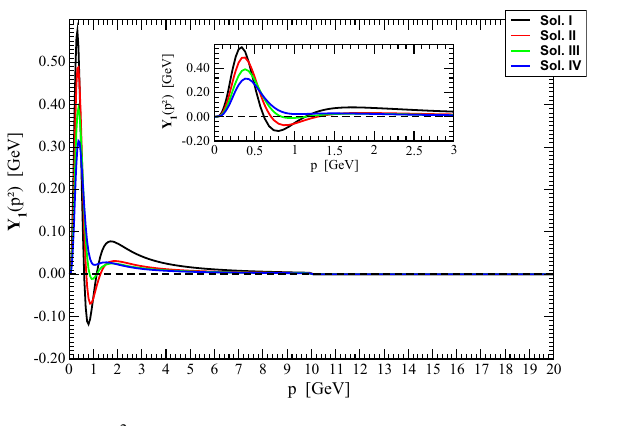
Fig. 21 Y 1 ( p 2 ) from inverting the Dyson–Schwinger equations